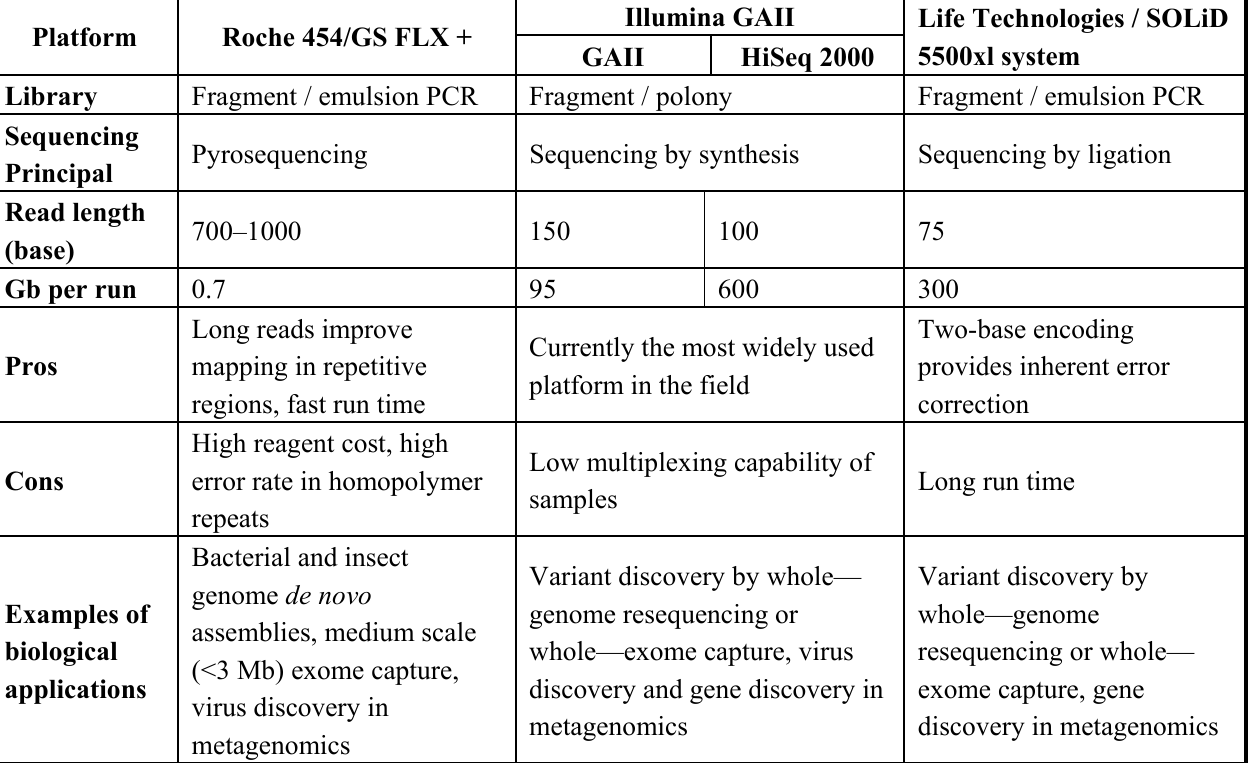
Table 1. Comparison of the most commonly used next generation sequencing platforms. (Modified from